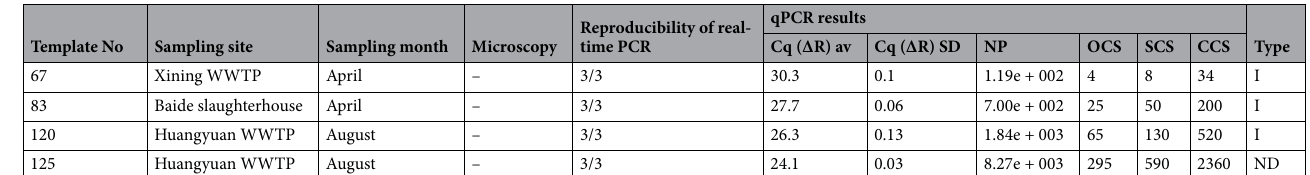
Table 2. Characteristics of the positive water samples collected from different water sources in Qinghai Province, P.R. China, regarding sampling time, reproducibility of real-time PCR results and the determined Toxoplasma genotype. (3/3) three positive results obtained per three repeats of real-time PCR. ND not determined, Cq (ΔR) av . average Cq values obtained from triplicates of positive water samples, Cq (ΔR) SD values of standard deviation obtained from triplicates of positive water samples, NP initial copy number (number of copies of T. gondii B1 gene) present in positive water samples calculated based on the standard curve, OCS the equivalent of the initial number of T. gondii oocysts present in positive water samples. SCS – the equivalent of the initial number of T. gondii sporocysts present in positive water samples (OCS × 2, one oocyst consist of two sporocysts). CCS equivalent of initial number of T. gondii cells (sporozoites) present in positive water samples (OCS × 8, one oocyst consist of two sporocysts filled with four sporozoites